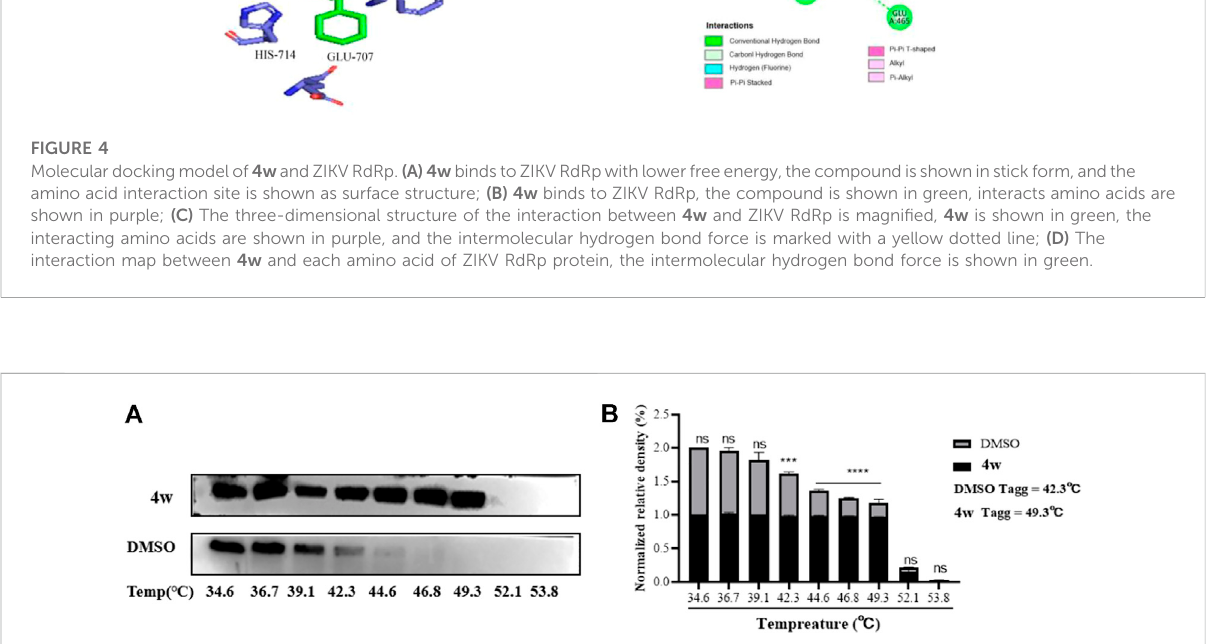
FIGURE 5 Theinteractionbetween 4w andZIKVNS5protein. (A) WBdetectionofZIKVNS5proteinexpressionunderdifferenttemperaturegradientsafter 4w treatment; (B) NS5proteingrayscaleanalysisandZIKVNS5proteinexpressionafter 4w treatmentobservedchangesinaggregationtemperature; data is the mean (±SD) of three experiments. * p < 0.05; ** p < 0.01; *** p < 0.001; **** p <